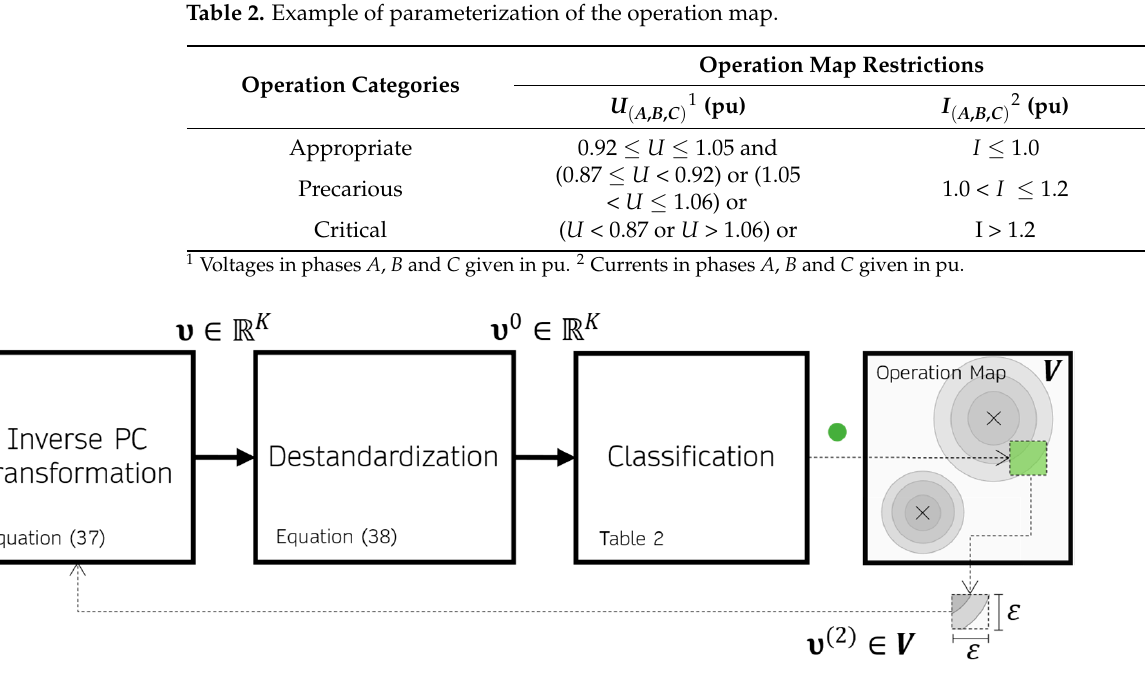
Figure 4. Flowchart of the operation map construction process. The green circle represents that the region was classified as appropriate. Table 2. Example of parameterization of the operation map. Operation Categories